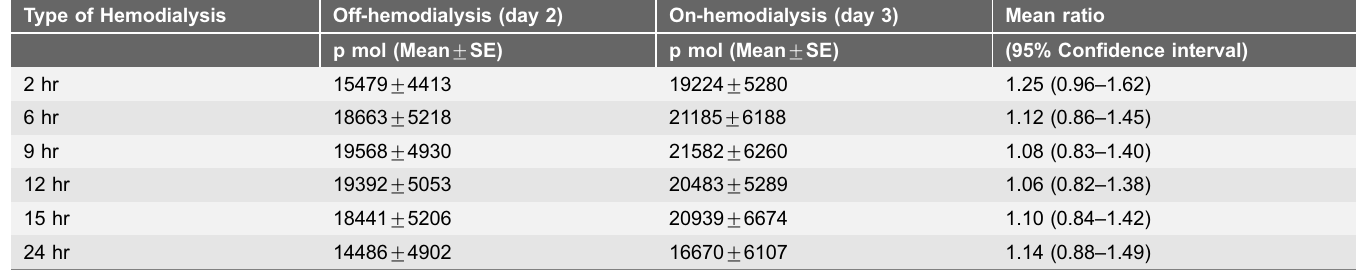
Table 2. Time-change profile of plasma liraglutide concentration following subcutaneous administration of liraglutide in diabetic patients with ESRD on the days of on-hemodialysis and off-hemodialysis. Type of Hemodialysis